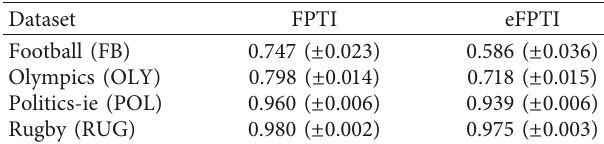
Figure 7: Feasibility validation of path reputation detection of the presented models. (a) Feedback detection. (b) Feed-forward detection. Table 4: Detection coverage in twitter networks.